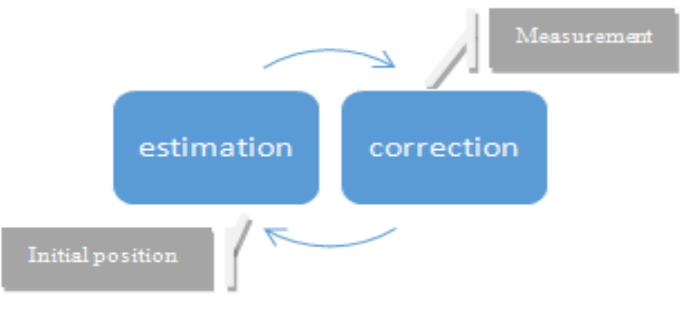
Figure 3. Correction process.